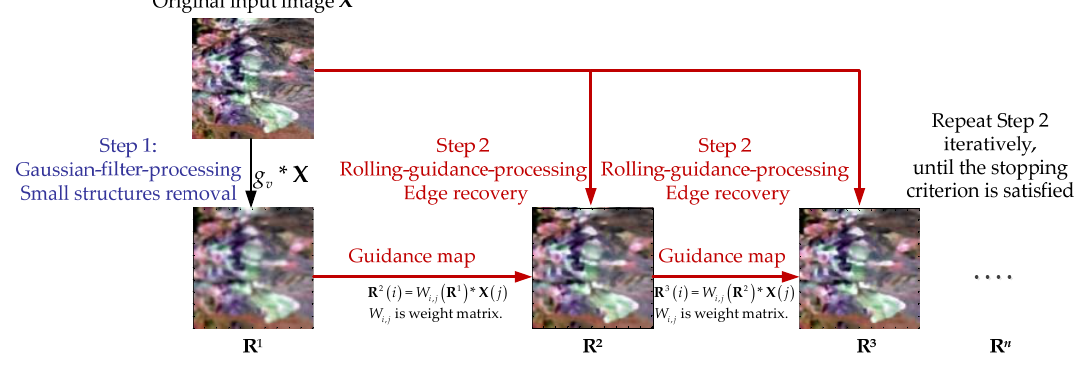
Figure 1. Flowchart of the scale-aware rolling guidance method.